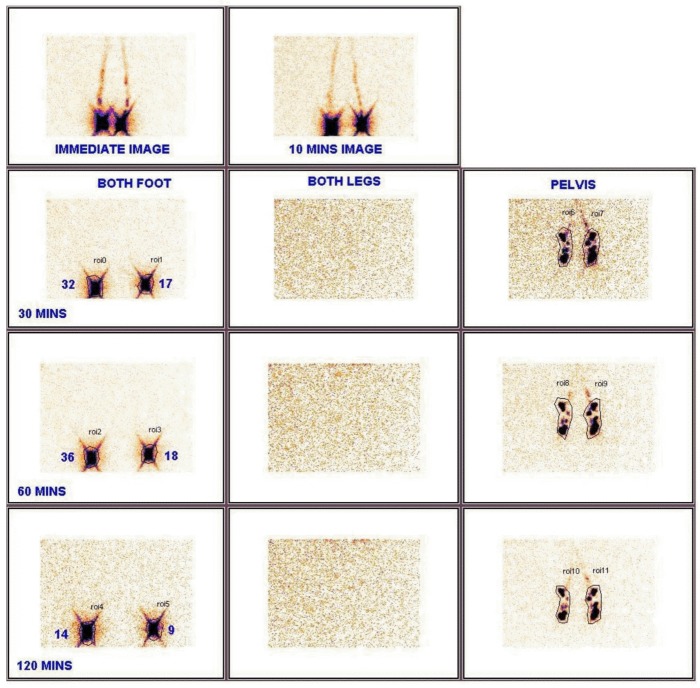
Normal images: 10, 30, 60, & 120 minute images of lymphoscintigraphy in a 14 yr male (asymptomatic and Mf positive).In both the limbs, at 10 minutes tracer movement into the lymphatics is seen in both legs and at 30 minutes inguinal nodes are visualized, lymphatic tract not imaged and tracer uptake symmetrical hence lymphatic flow normal in both legs. Note the granular appearance in leg images is typical of background noise where there is no additional tracer image.